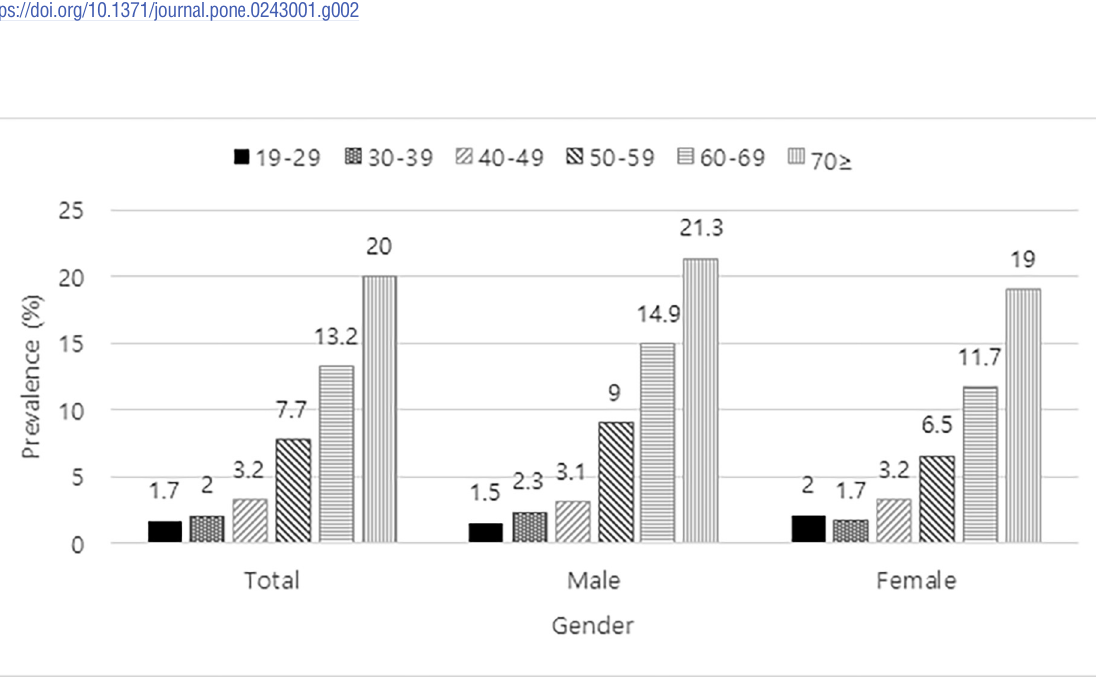
PLOS ONE | https://doi.org/10.1371/journal.pone.0243001 December1,